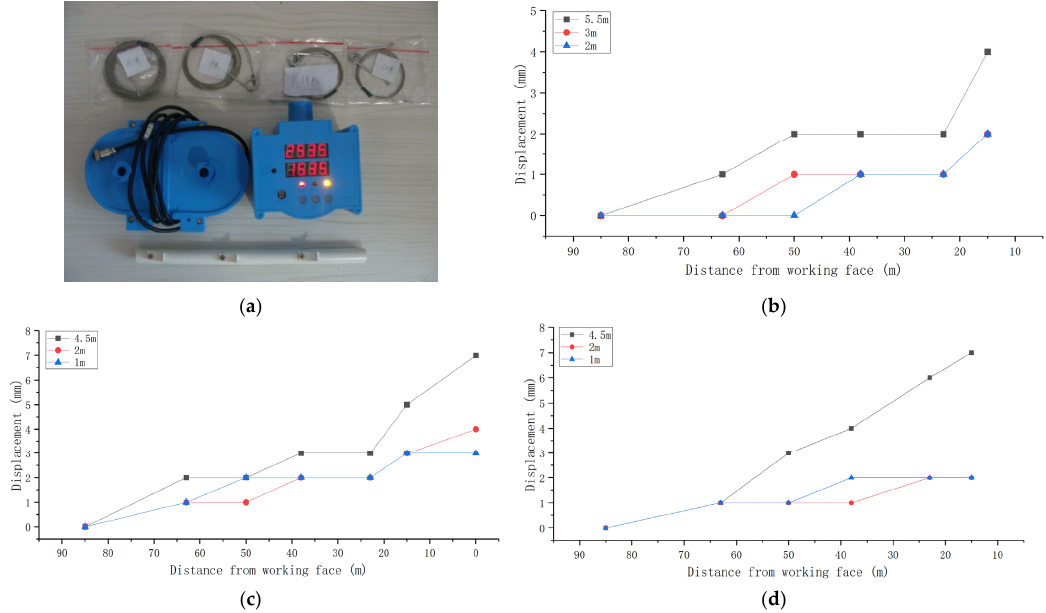
Figure 12. Surrounding rock deformation: ( a ) field-monitoring instrument; ( b ) deformation trend of roof; ( c ) deformation trend of coal wall side; ( d ) deformation trend of coal pillar side.